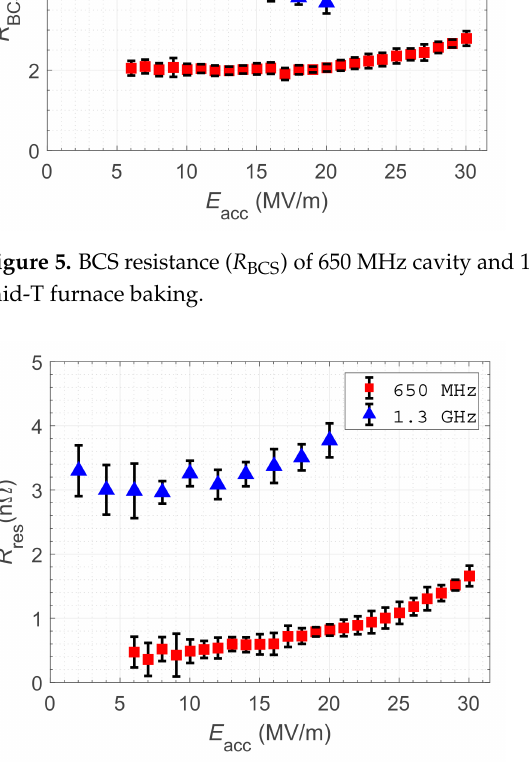
Figure 6. Residual resistance ( R res ) of 650 MHz cavity and 1.3 GHz cavity, which both received mid-T furnace